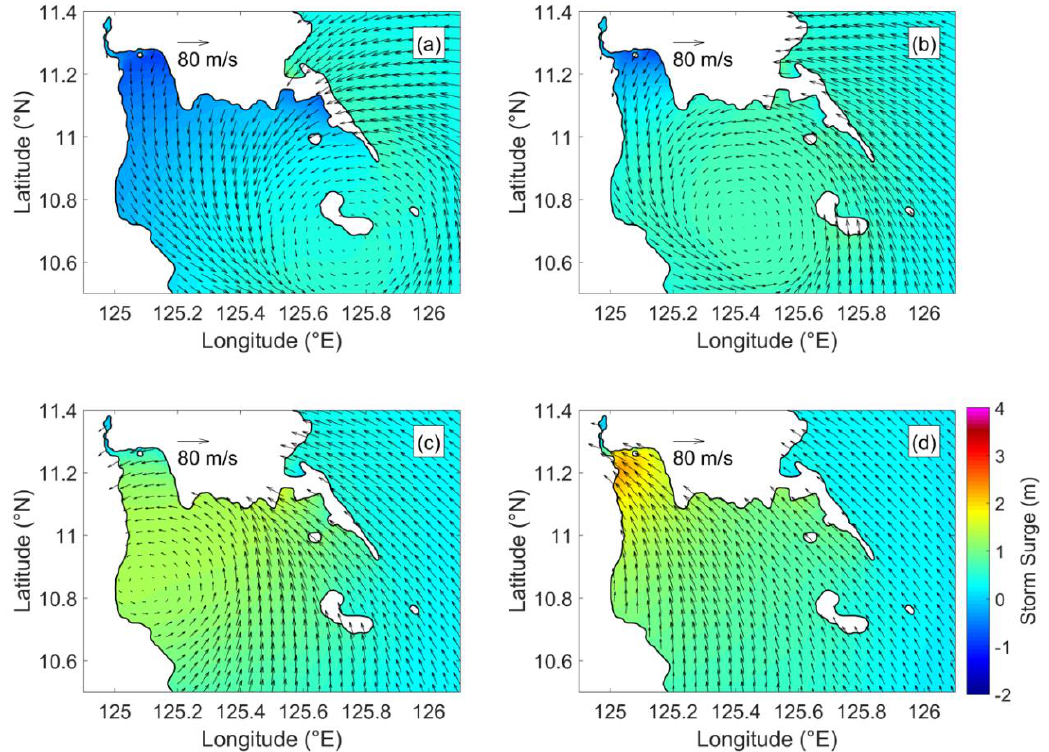
Figure 12. Snapshots of the computed storm surges driven by WRF-ARW 3 km at the times of: ( a ) 01:00 UTC 8 November 2013; ( b ) 02:00 UTC 8 November 2013; ( c ) 03:00 UTC 8 November 2013; ( d ) 04:00 UTC 8 November 2013. The color shading indicates the storm surge in m, and the black line depicts the coastline of the storm surge model. The arrows depict the 10-m winds of WRF-ARW 3 km per every 15 grids over the domain. These snapshots have been zoomed in from the original computational domain.